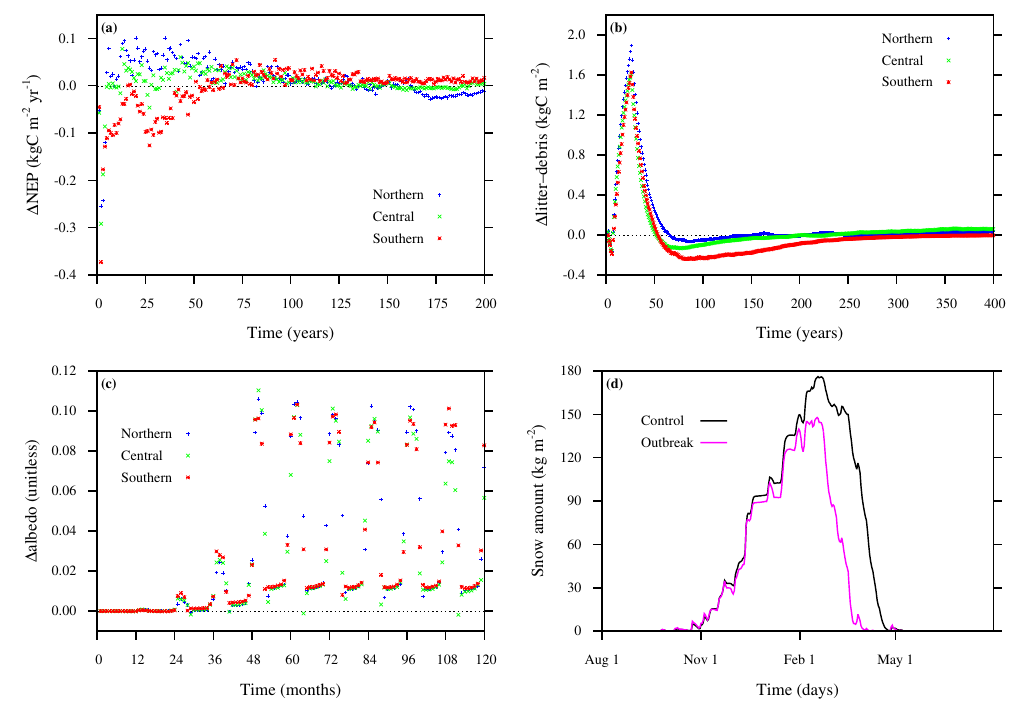
Figure 3. Impact of an MPB outbreak (100% mortality) simulated in IBIS–MIM on different variables over various timescales. (a) Change (outbreak minus control) in NEP for the three grid cells; mortality happened on year 1. (b) Change (outbreak minus control) in aboveground litter (including coarse woody debris, but excluding dead standing trees) for the three grid cells; mortality happened on year 1. (c) Change (outbreak minus control) in albedo for the three grid cells; mortality happened on months 8 and 9 (August and September). (d) Snow amount in the central grid cell for the control and outbreak simulations; mortality happened 8 years